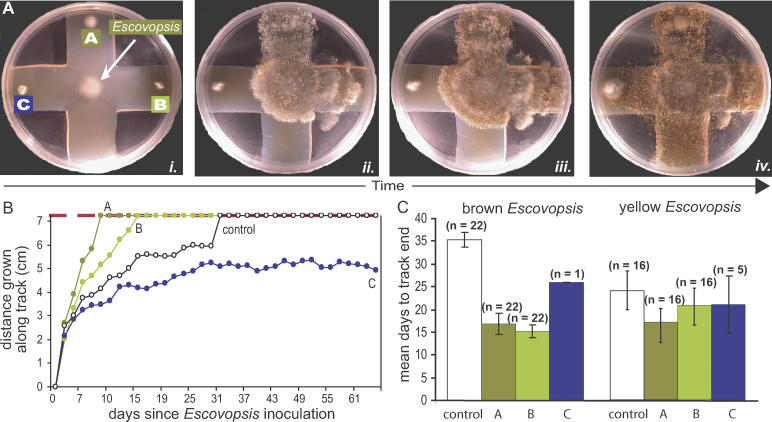
Fungal-Choice Bioassays(A) Isolates of cultivars A, B, and C are placed at the end of each of three tracks, and one track remains blank as a control. Brown
Escovopsis begins to grow concentrically (i), but over time overgrows cultivar A (ii), then cultivar B (iii), then the end of the control track (iv)
. After several months, the parasite has still not overcome the zone of inhibition surrounding cultivar C (iv).
(B) Progression of
Escovopsis growth over time on the plate shown in (A); the red, dashed line indicates the track end, at which the pathogen overgrows the cultivar.
(C) Average number of days to reach each cultivar type in fungal-choice bioassays. For cultivar C, results are included only for trials in which
Escovopsis was able to overgrow cultivar C and reach the end of the track.